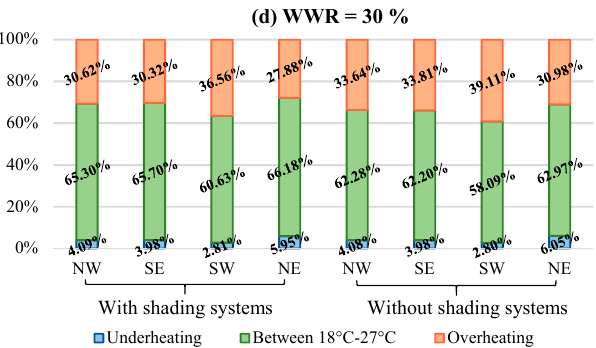
Figure 17. Comfort rates varying according to different WWR by orientation with and without the use of shading systems.